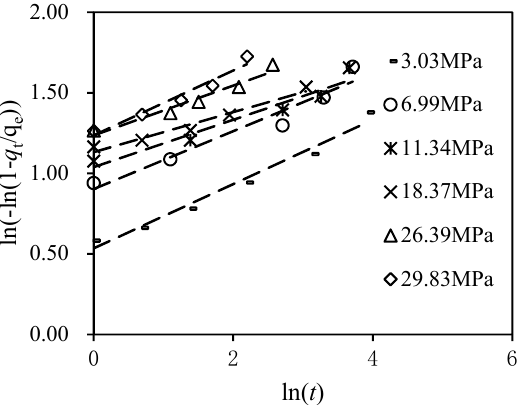
Figure 6. Fitting methane adsorption dynamic using Bangham model at 40 ◦ C. Table 2. The results of fitting methane adsorption dynamic using Bangham model at 40 °C.